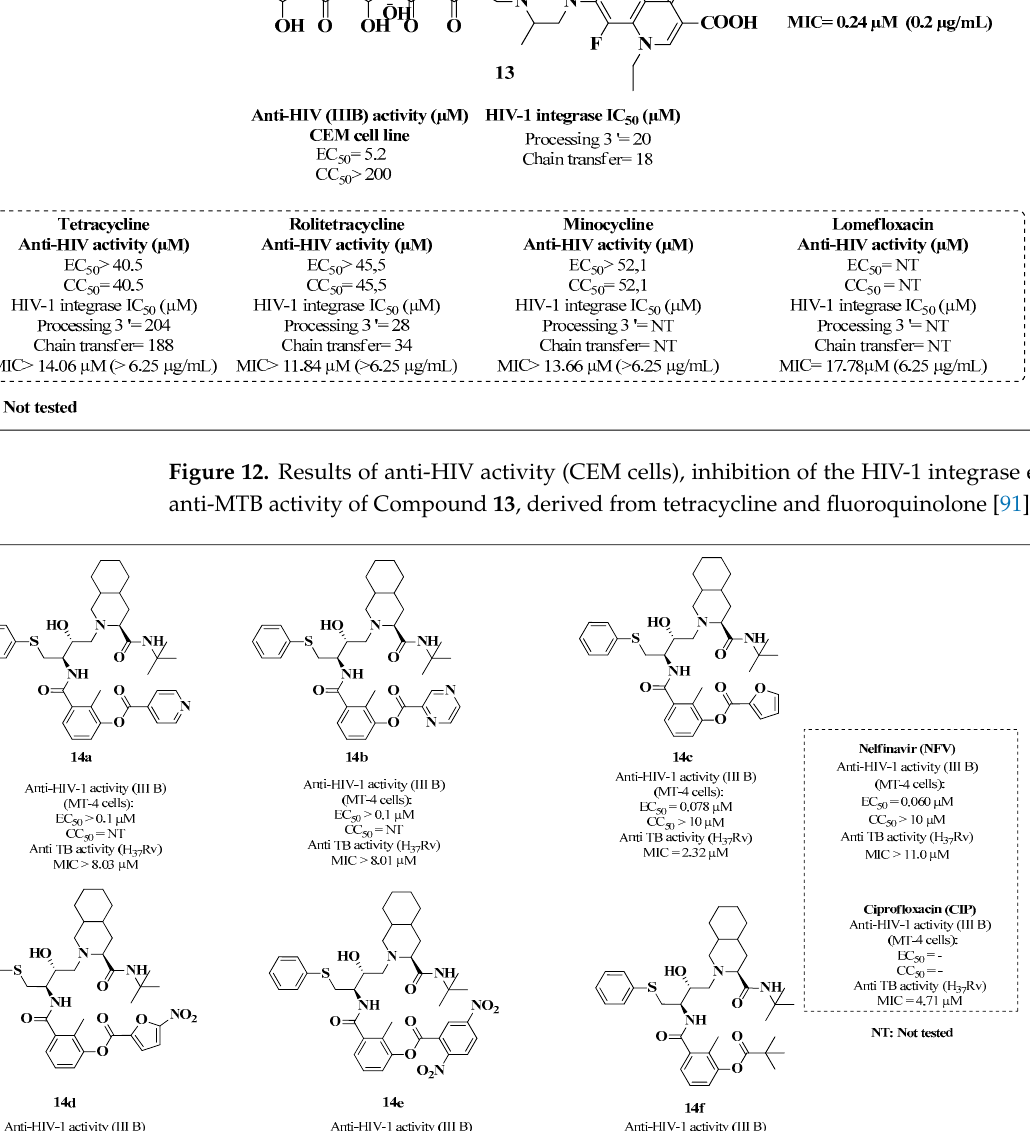
Figure 12. Results of anti-HIV activity (CEM cells), inhibition of the HIV-1 integrase enzyme and anti-MTB activity of Compound 13 , derived from tetracycline and fl uoroquinolone [91].